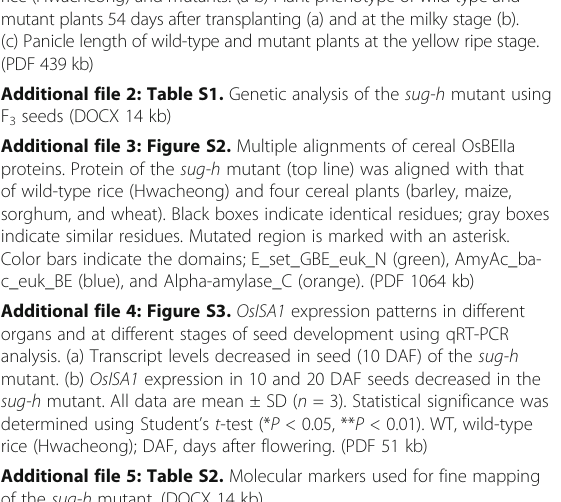
Additional file 1: Figure S1. Plant and panicle morphology of wild-type rice (Hwacheong) and mutants. (a-b) Plant phenotype of wild-type and mutant plants 54 days after transplanting (a) and at the milky stage (b). (c) Panicle length of wild-type and mutant plants at the yellow ripe stage. (PDF 439 kb) Additional file 2: Table S1. Genetic analysis of the sug-h mutant using F Additional file 3: Figure S2. Multiple alignments of cereal OsBEIIa proteins. Protein of the sug-h mutant (top line) was aligned with that of wild-type rice (Hwacheong) and four cereal plants (barley, maize, sorghum, and wheat). Black boxes indicate identical residues; gray boxes indicate similar residues. Mutated region is marked with an asterisk. Color bars indicate the domains; E_set_GBE_euk_N (green), AmyAc_ba- c_euk_BE (blue), and Alpha-amylase_C (orange). (PDF 1064 kb) Additional file 4: Figure S3. OsISA1 expression patterns in different organs and at different stages of seed development using qRT-PCR analysis. (a) Transcript levels decreased in seed (10 DAF) of the sug-h mutant. (b) OsISA1 expression in 10 and 20 DAF seeds decreased in the sug-h mutant. All data are mean ± SD ( n = 3). Statistical significance was determined using Student ’ s t -test (* P < 0.05, ** P < 0.01). WT, wild-type rice (Hwacheong); DAF, days after flowering. (PDF 51 kb) Additional file 5: Table S2. Molecular markers used for fine mapping of the sug-h mutant. (DOCX 14